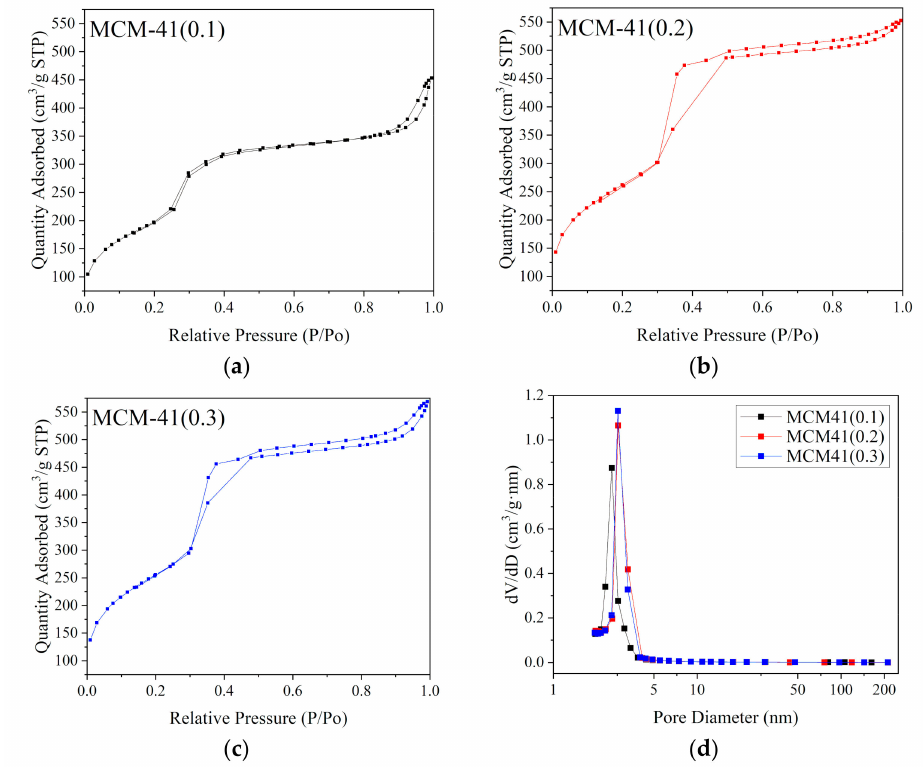
Figure 4. N 2 adsorption-desorption isotherms ( a – c ) and pore diameter distribution curves ( d ) of